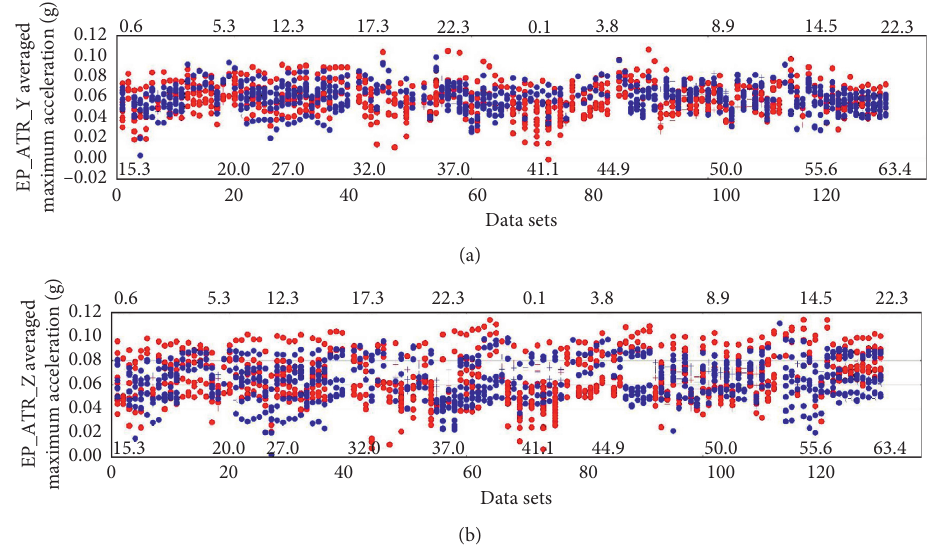
Figure 12: Low-pass filtered (15Hz) acceleration on CBSE traction converter in (a) lateral and (b) vertical directions. 0.03